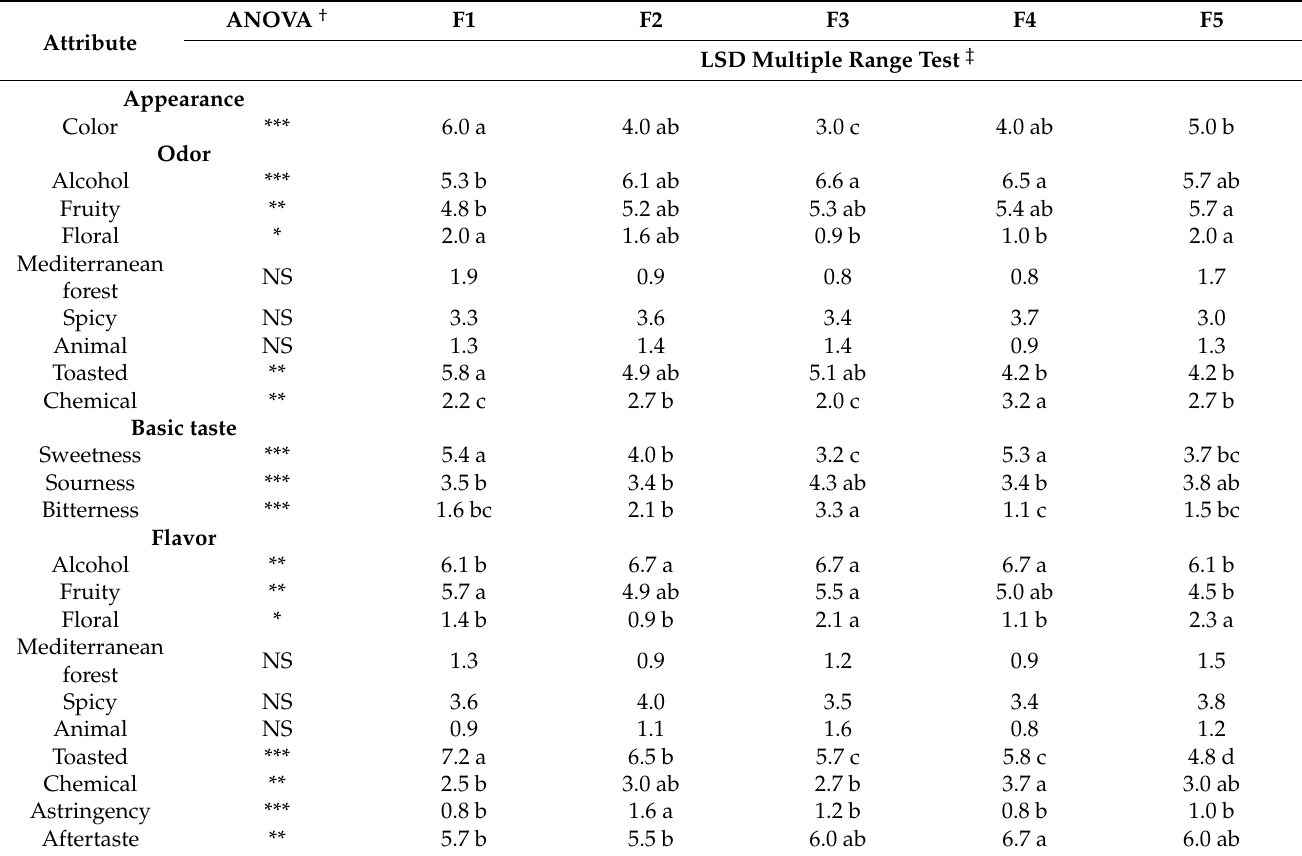
Table 1. Descriptive sensory profile of the Fondill ó n samples under analysis.